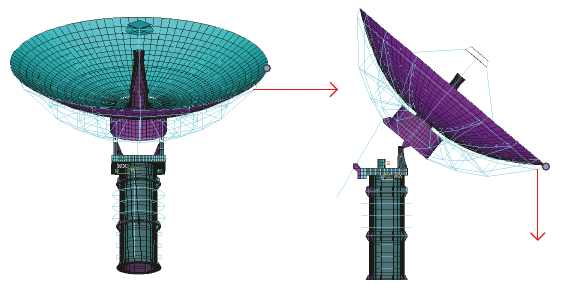
Figure 6: The position and direction of the applied load.